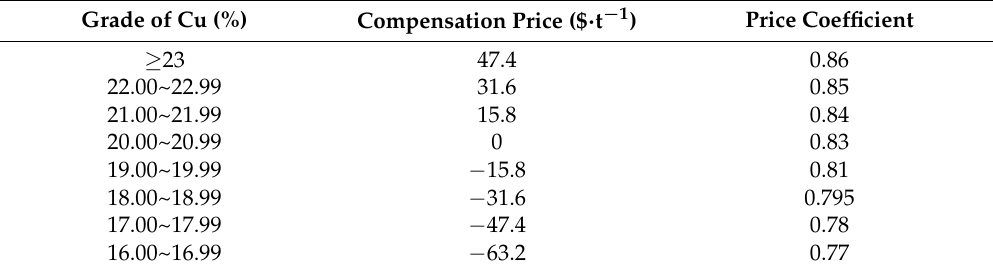
Table 2. Compensation prices and price coefficients of different copper concentrate grades.